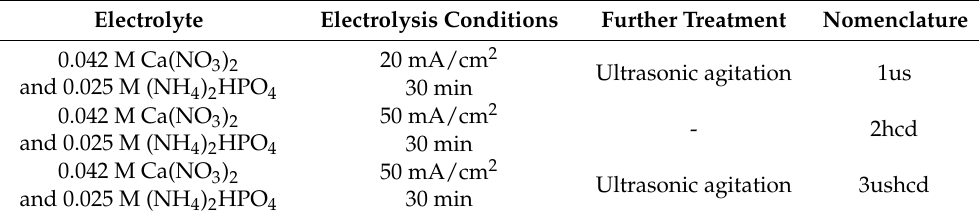
Table 1. Nomenclature of the